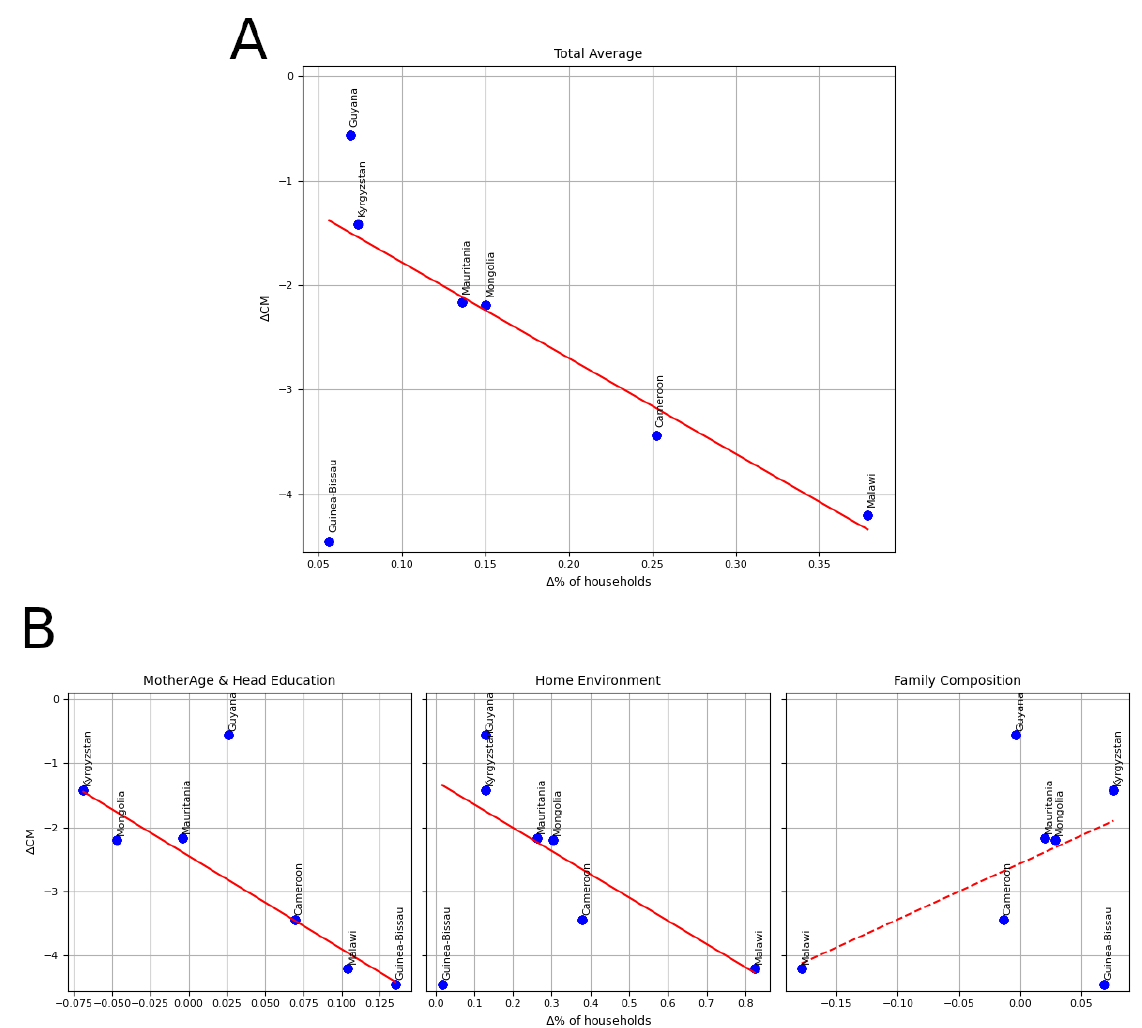
Figure 3. Association between the improvement of distal causes and CM. ∆ CM: variation of the incidence of Child Mortality between round 3 and 5; ∆ %: variation of the percentage of households with improved characteristics. ( A ). Total Improvement; ( B ). Three groups of distal causes: Mother Age and Head Education (left), House Environment (middle), and Family Composition (right). Solid lines indicate a significant association, according to the linear regression models (Table 2); dashed lines indicate non significant